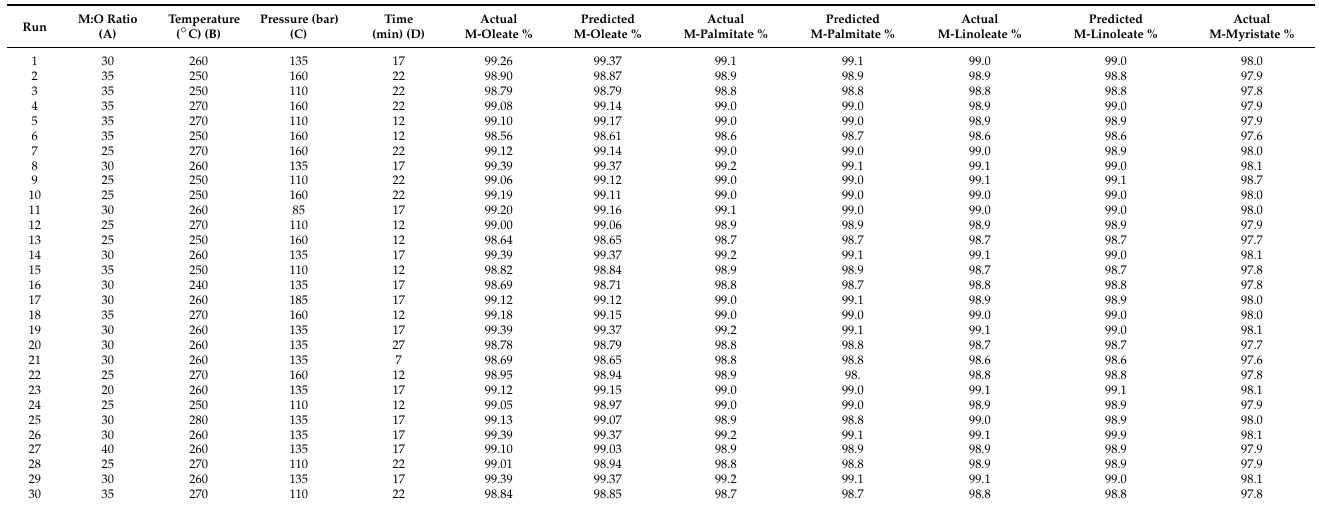
Table A1. Analysis of variance for FAME yield of methyl-palmitate model.